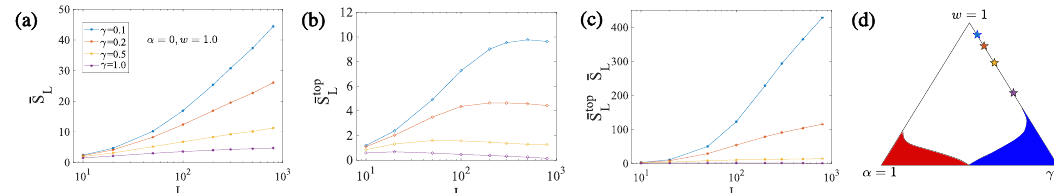
, L and (c) ¯ S × ¯ S top . (d) Indicates where the L L